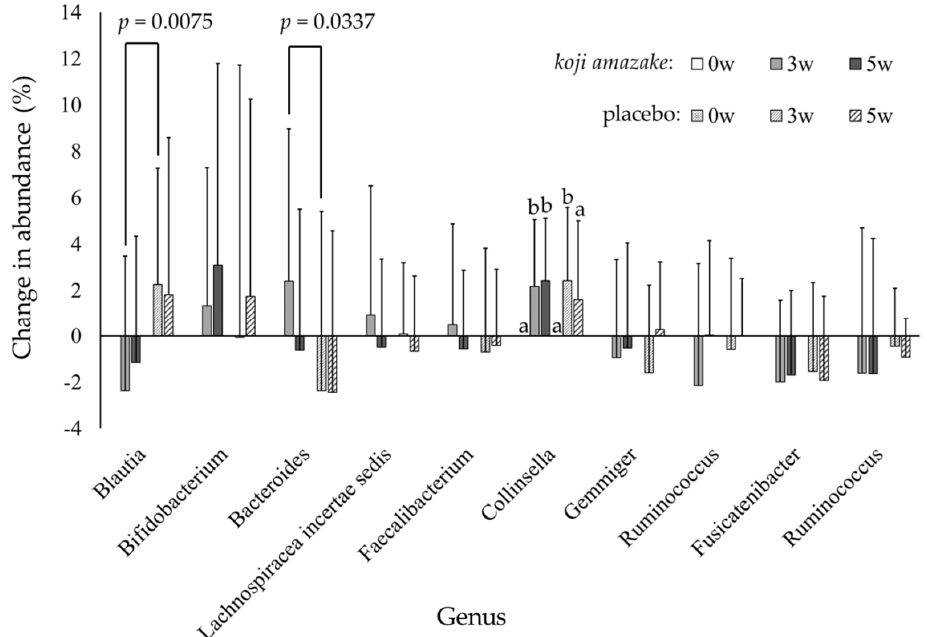
Figure 3. Inter − and intra − group comparison of the changes in ∆ relative abundance from baseline values (0 w) to 3 w and in each of ten dominant bacterial genera of the koji amazake and placebo groups. Each value is expressed as mean ± standard deviation. Delta ( Δ ) relative abundance is the change in relative abundance compared with the value at baseline. Statistical analyses: p values indicate significant inter − group difference, analyzed using repeated measures ANOVA ( Blautia : group p = 0.0193, time p = 0.8846, group × time p = 0.0276; Bacteroidetes : group p = 0.0830, time p = 0.2191, group × time p = 0.0617) followed by a t − test. a, b Columns with different letters indicate significant difference ( p < 0.05), with intra-group comparison in each group of each genus at three time points, as calculated using Dunnett’s multiple comparisons test. Table 4. Comparison of relative abundances at three time points (0 w, 3 w, and 5 w) of koji amazake and placebo groups in each bacterial genus with relative abundance more than 1.0%.